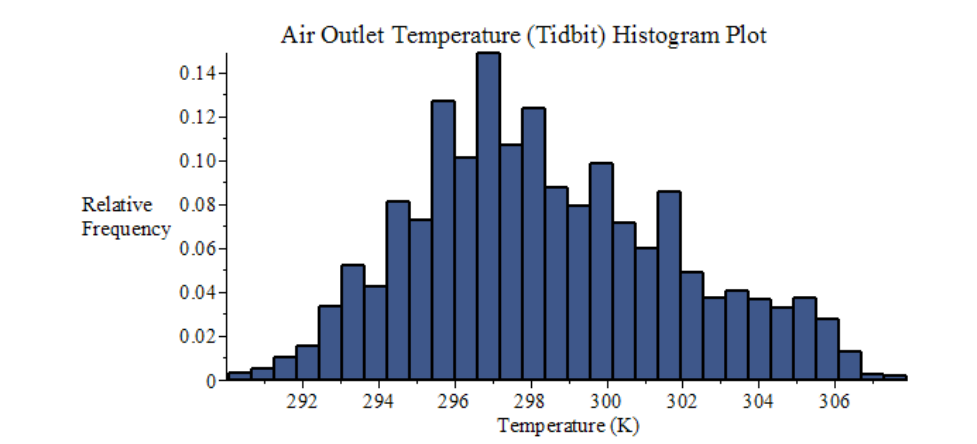
Table A1. Statistics of the air outlet relative humidity distribution [%].